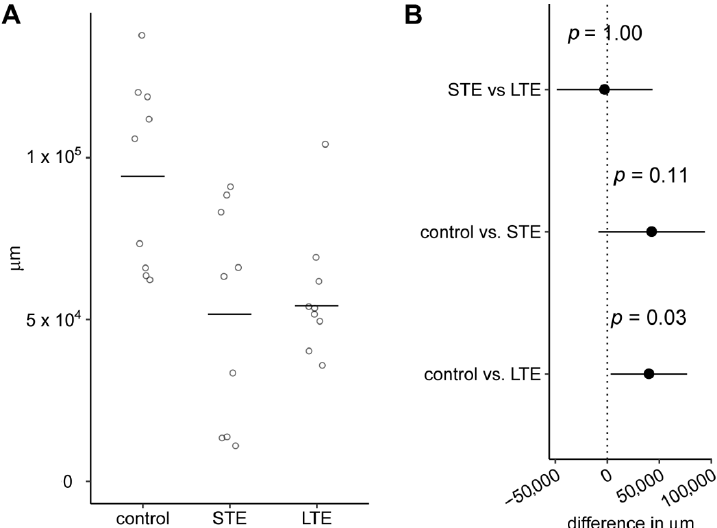
Figure 3. Effect of blue light exposure on length of melanopsin positive intrinsically photosensitive retinal ganglion cell (ipRGC) dendrites. The rats were exposed to 12 h white light (150 lx) and 12 h darkness for 10 d (control, 9 rats), cycles of 12 h blue light (150 lx) and 12 h darkness for 10 d (long-term exposure, LTE; 9 rats), and constant blue light (150 lx) for 2 d (short-term exposure, STE; 9 rats). ( A ) Circles show total length of all melanopsin-positive ipRGC processes in a 2.560 mm 2 area of a retinal whole-mount from one rat. Horizontal lines show 20%-trimmed means. ( B ) Dot shows difference between group means. Error bar shows 95% confidence interval for the difference. p -values and confidence intervals were calculated with Wilcox’s robust technique based on trimmed means [34,35].